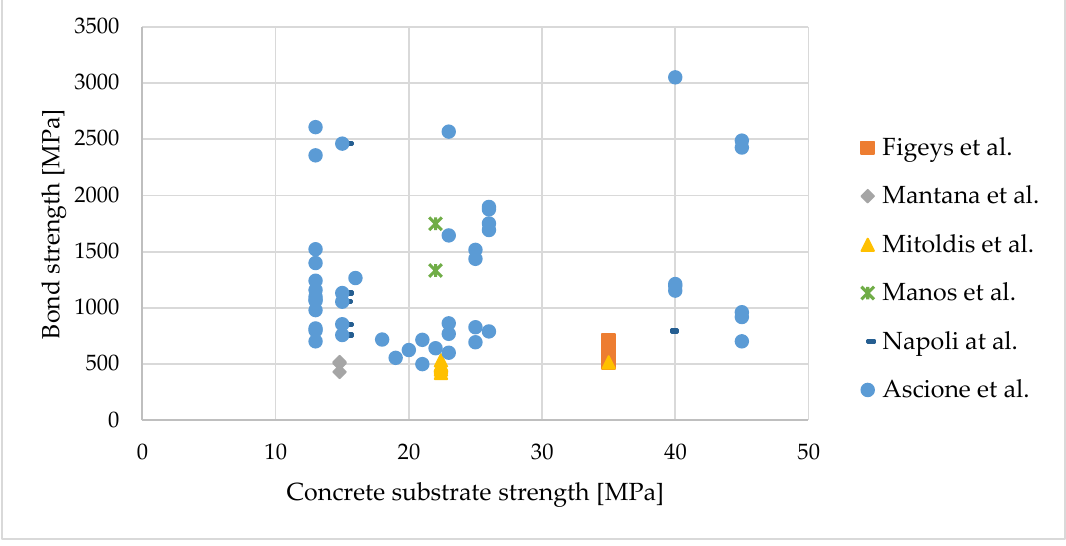
Figure 3. Review of bond strength test results concerning concrete substrate [15–20].